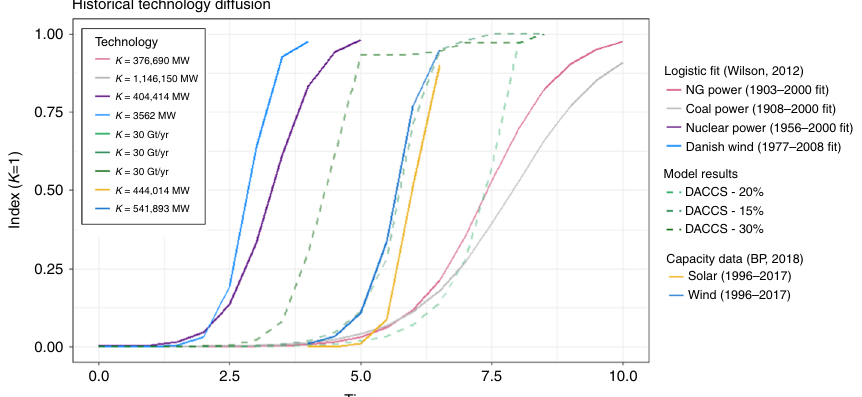
Fig. 5 Comparison of DACCS up-scaling with historical technology diffusion. Past technology diffusion pathways are based on data from Wilson 33 and recent statistics for solar PV and wind 35 . As these technologies have been diffusing in different years and with different scales (i.e. the extent K reached by the logistic pro fi le), we have normalized the data indexing the capacity extent K to 1, and we have harmonized the starting year ( t = 0), considering a unit time scale equal to one